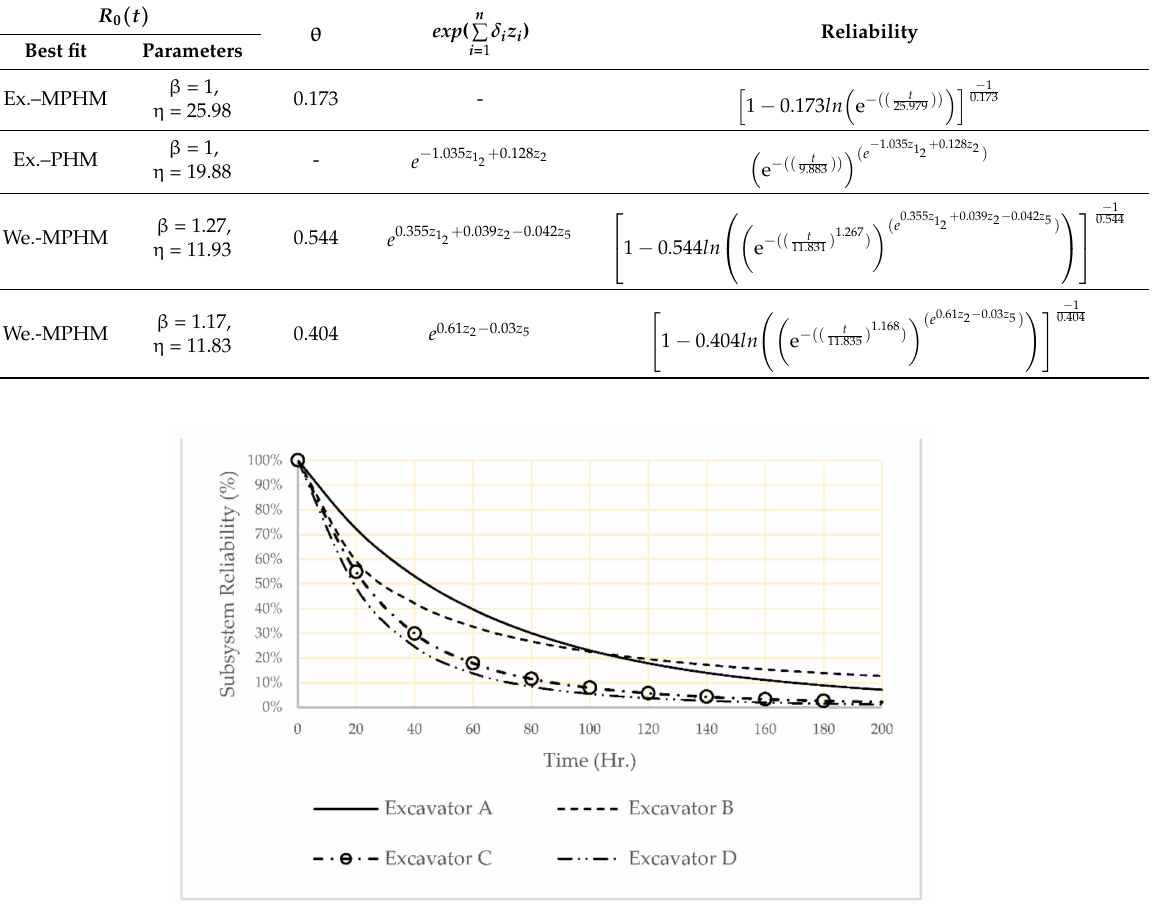
Table 6. The results baseline function and regression coefficients estimation.